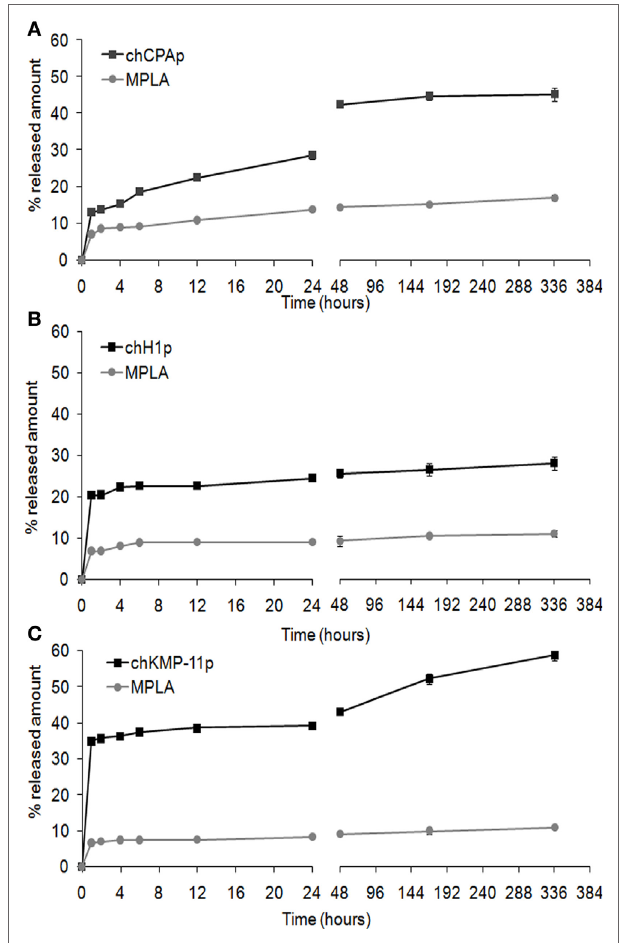
FigUre 1 | In vitro release profile of the chimeric peptides from peptide- based poly(lactic- co -glycolic) acid (PLGA) nanoformulations. Time-dependent release of chCPAp and monophosphoryl lipid A (MPLA) adjuvant from PLGA-chCPAp-MPLA nanoformulations (a) , chH1p and MPLA adjuvant from PLGA-chH1p-MPLA nanoformulations (B) , and chKMP-11p and MPLA adjuvant from PLGA-chKMP-11p-MPLA nanoformulations (c) into PBS at 37°C. Data represent the mean ± SD of three independent